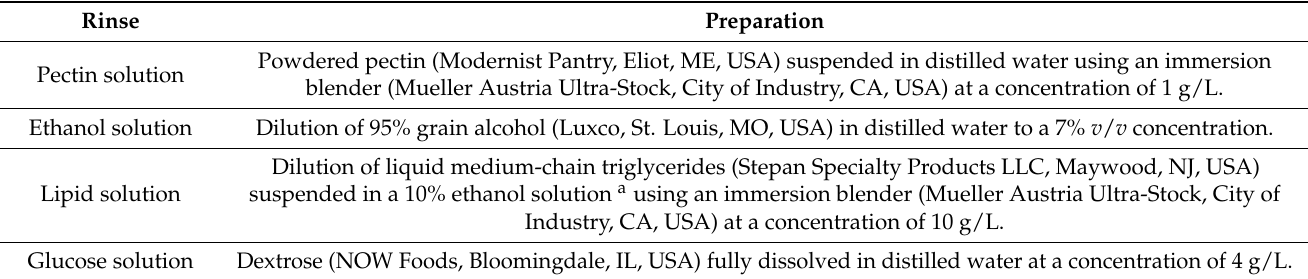
Table 2. Rinses evaluated during the fixed-time point evaluation. Rinse